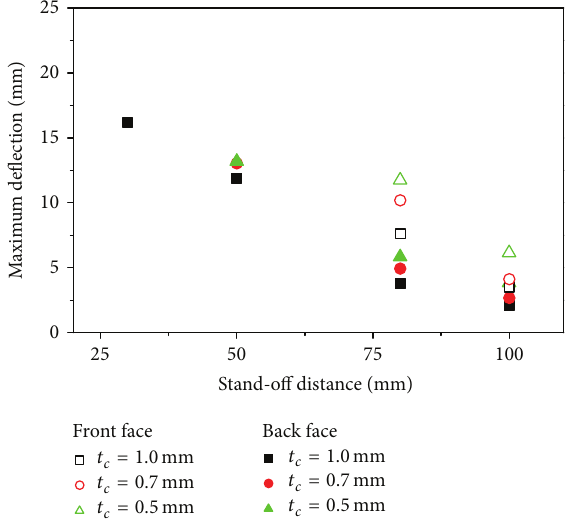
Figure 20: Maximum deflections of back face of sandwich panels with different relative density of